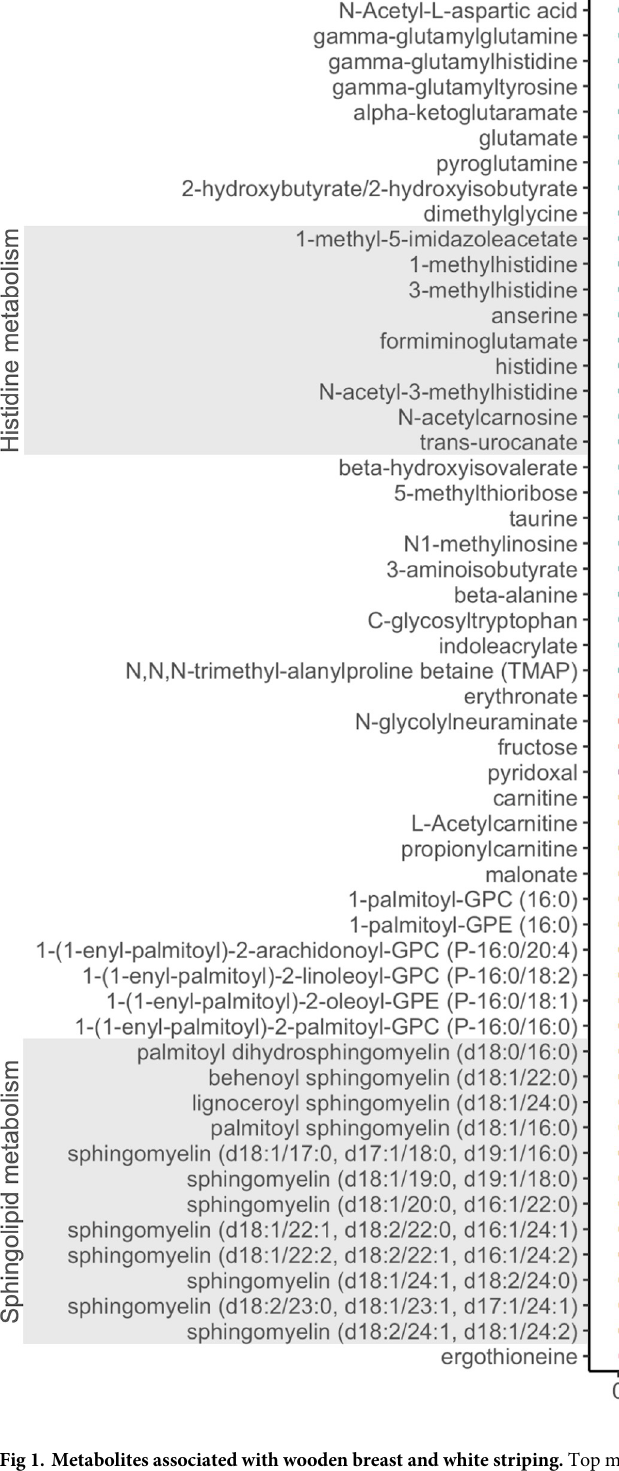
PLOS ONE | https://doi.org/10.1371/journal.pone.0274208 September 26,